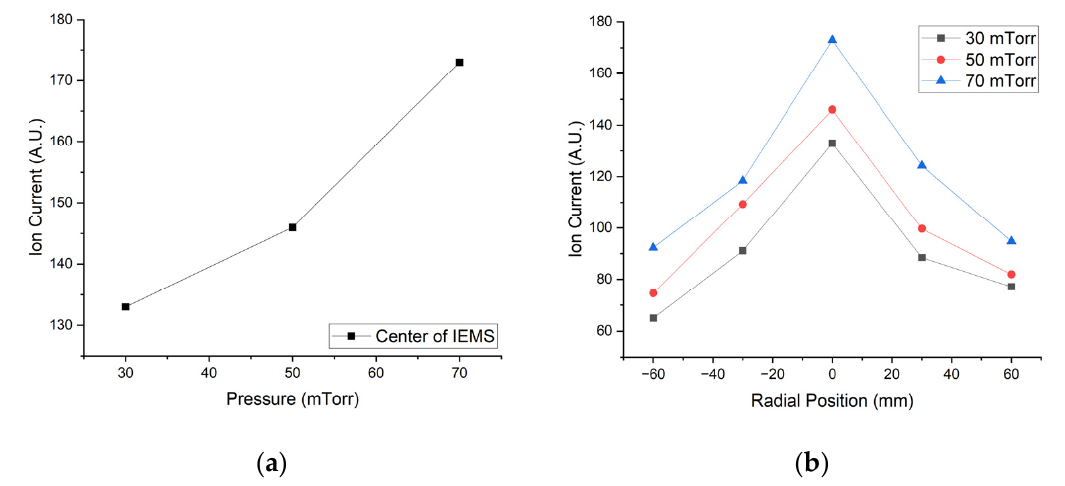
Figure 10. Experimental result according to pressure change; ( a ) Center position and ( b ) Middle axis. All data were acquired 30 s after plasma generation for stabilization.